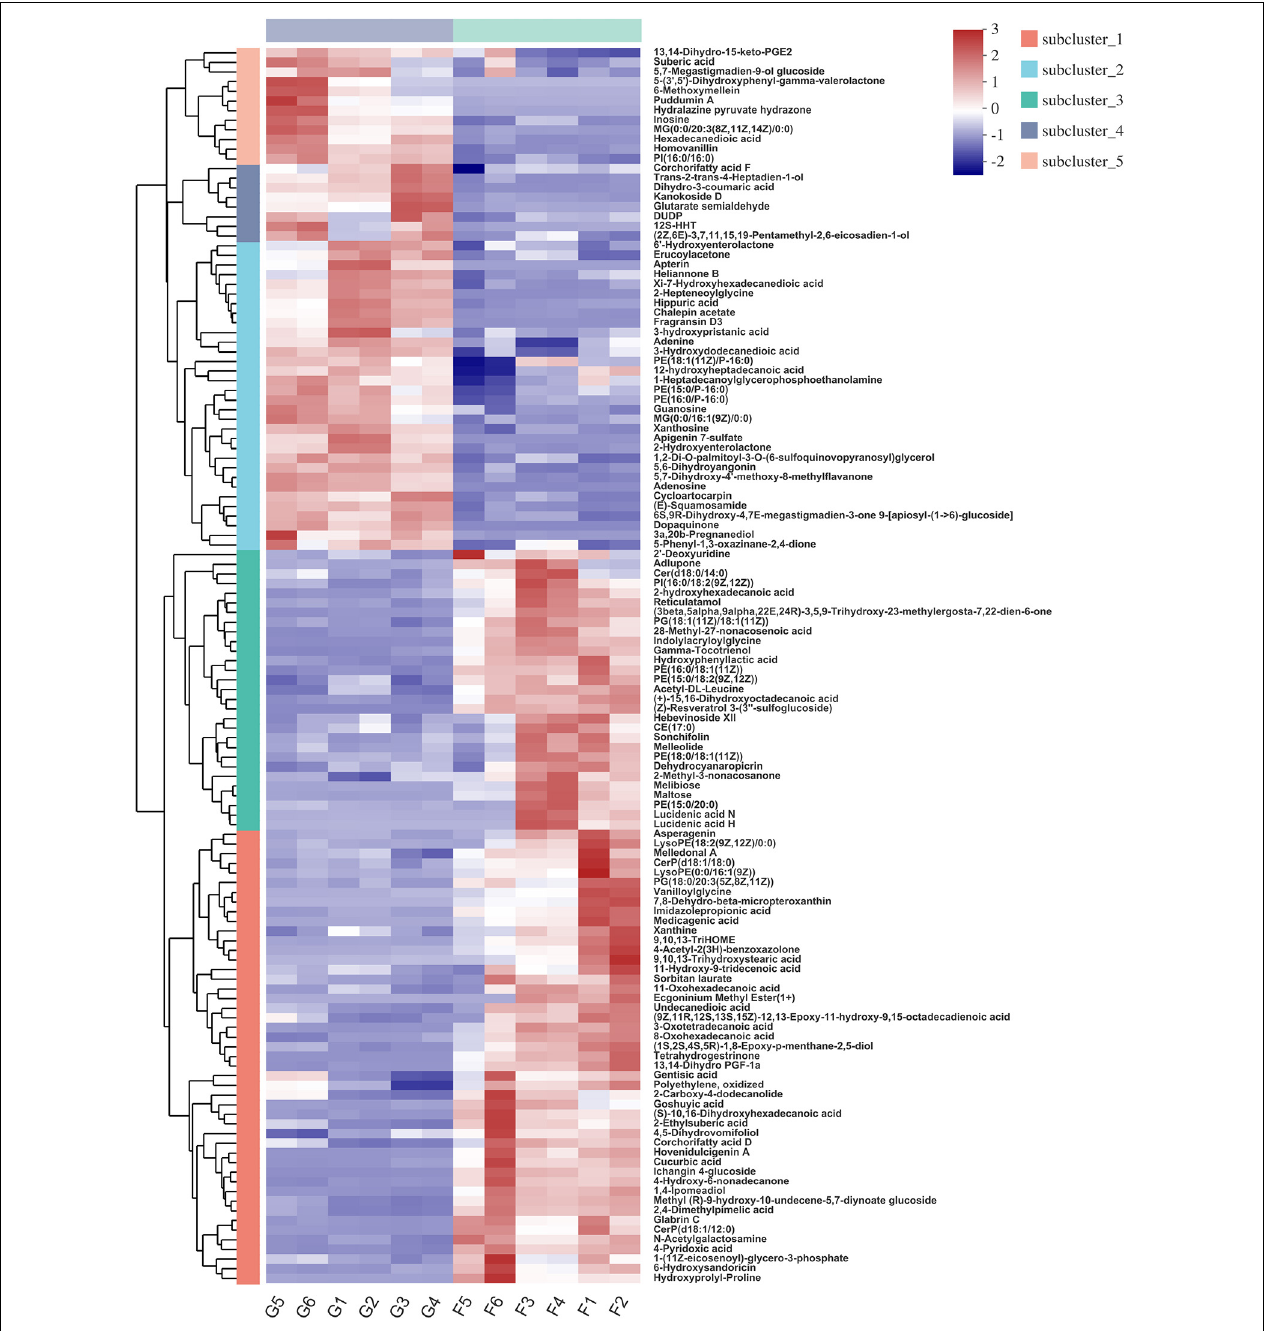
FIGURE 7 | Hierarchical clustering analysis (HCA) with a heat map for the expression of different metabolites in yak rumen between grazing group and house fattening group following negative mode